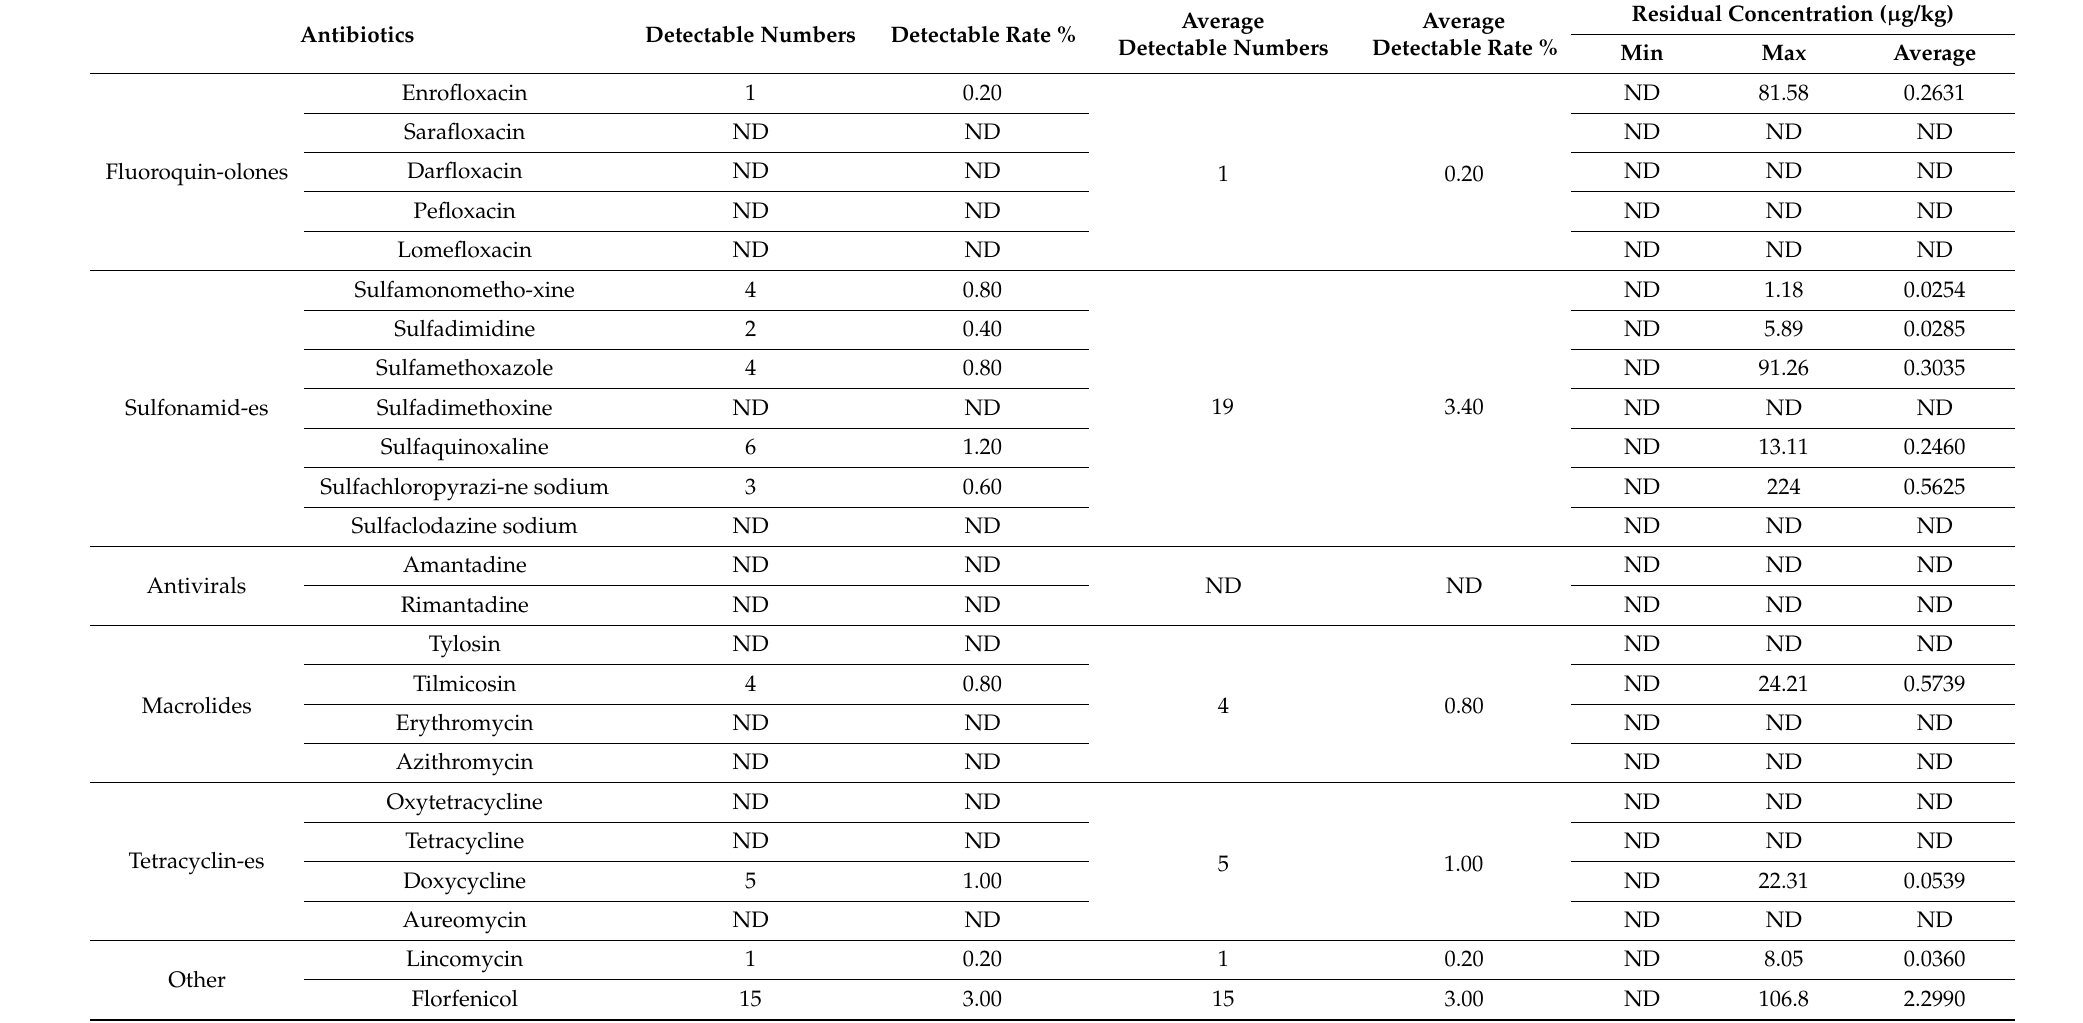
Table 3. Residues of antibiotics in eggs in